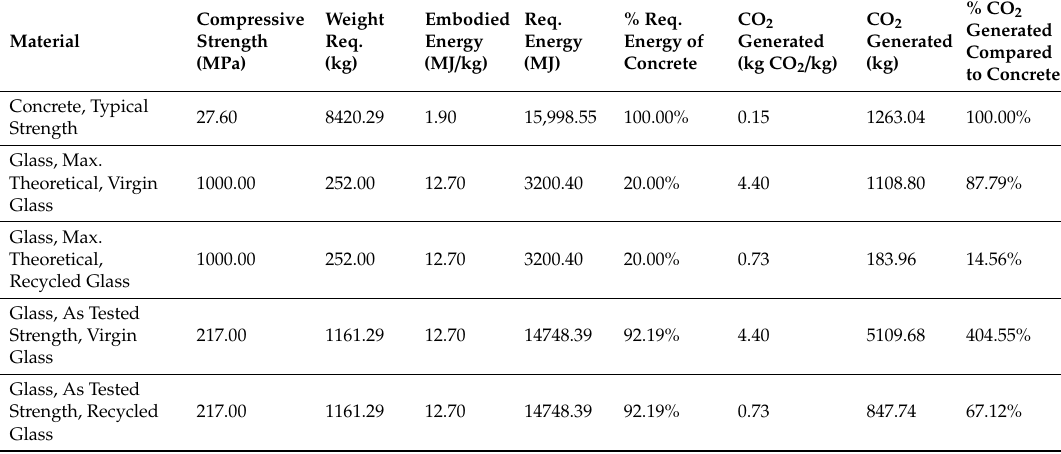
Table 3. The embodied energy (an estimate of the energy to produce a material, which correlates with fossil fuel usage during the manufacturing of the material) and CO 2 generated for concrete and glasses are shown. Glass outperforms concrete in certain